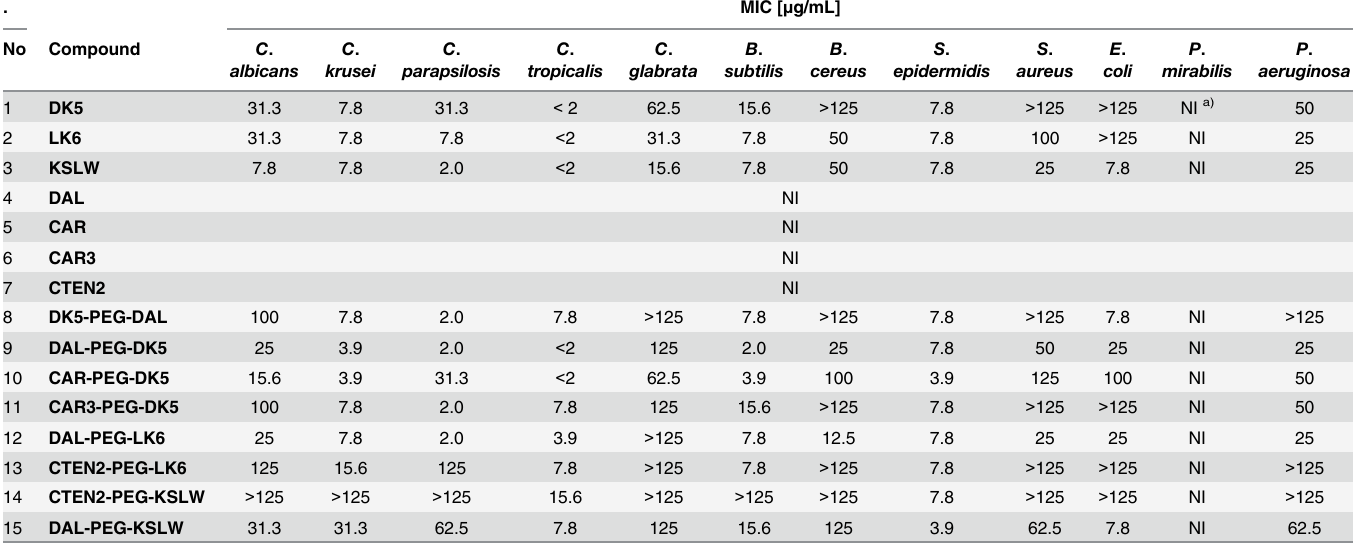
Table 2. Antimicrobial activity of the